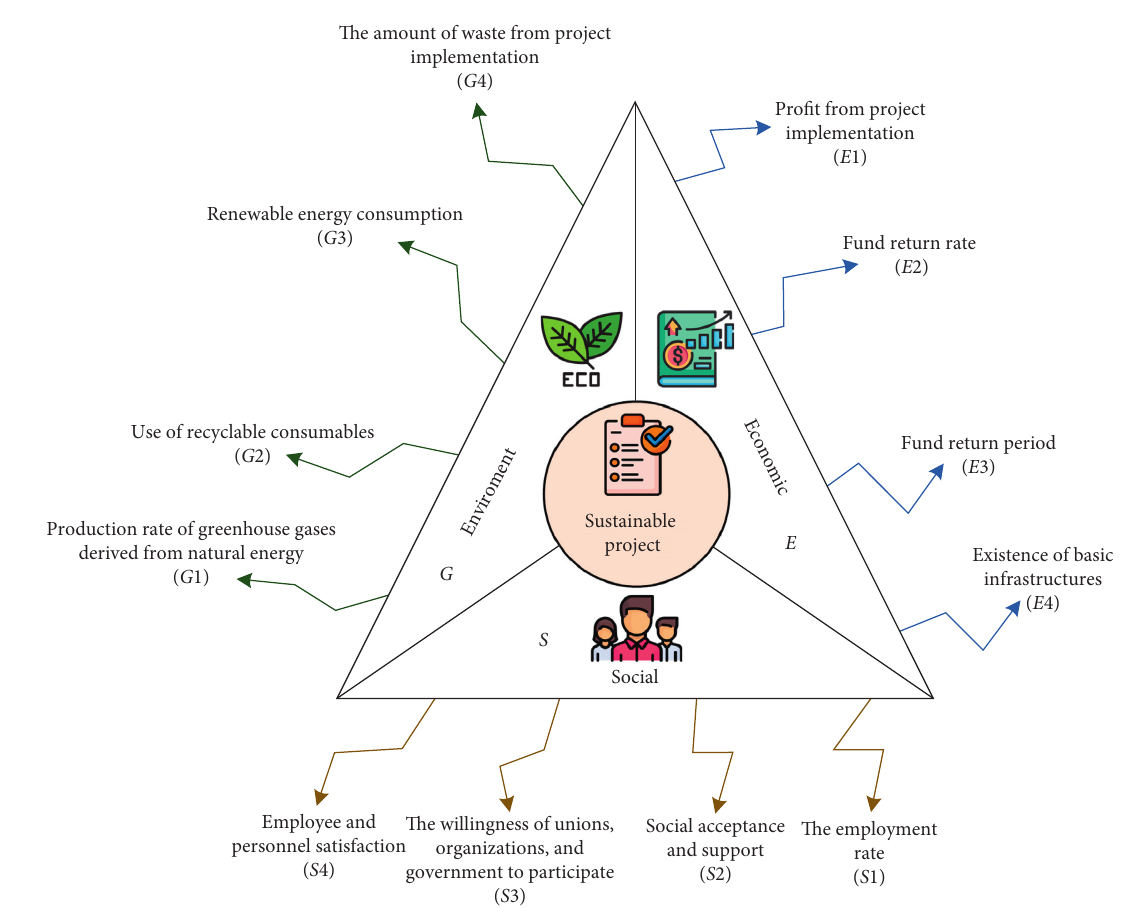
Figure 6: Sustainability dimensions and criteria selected in this